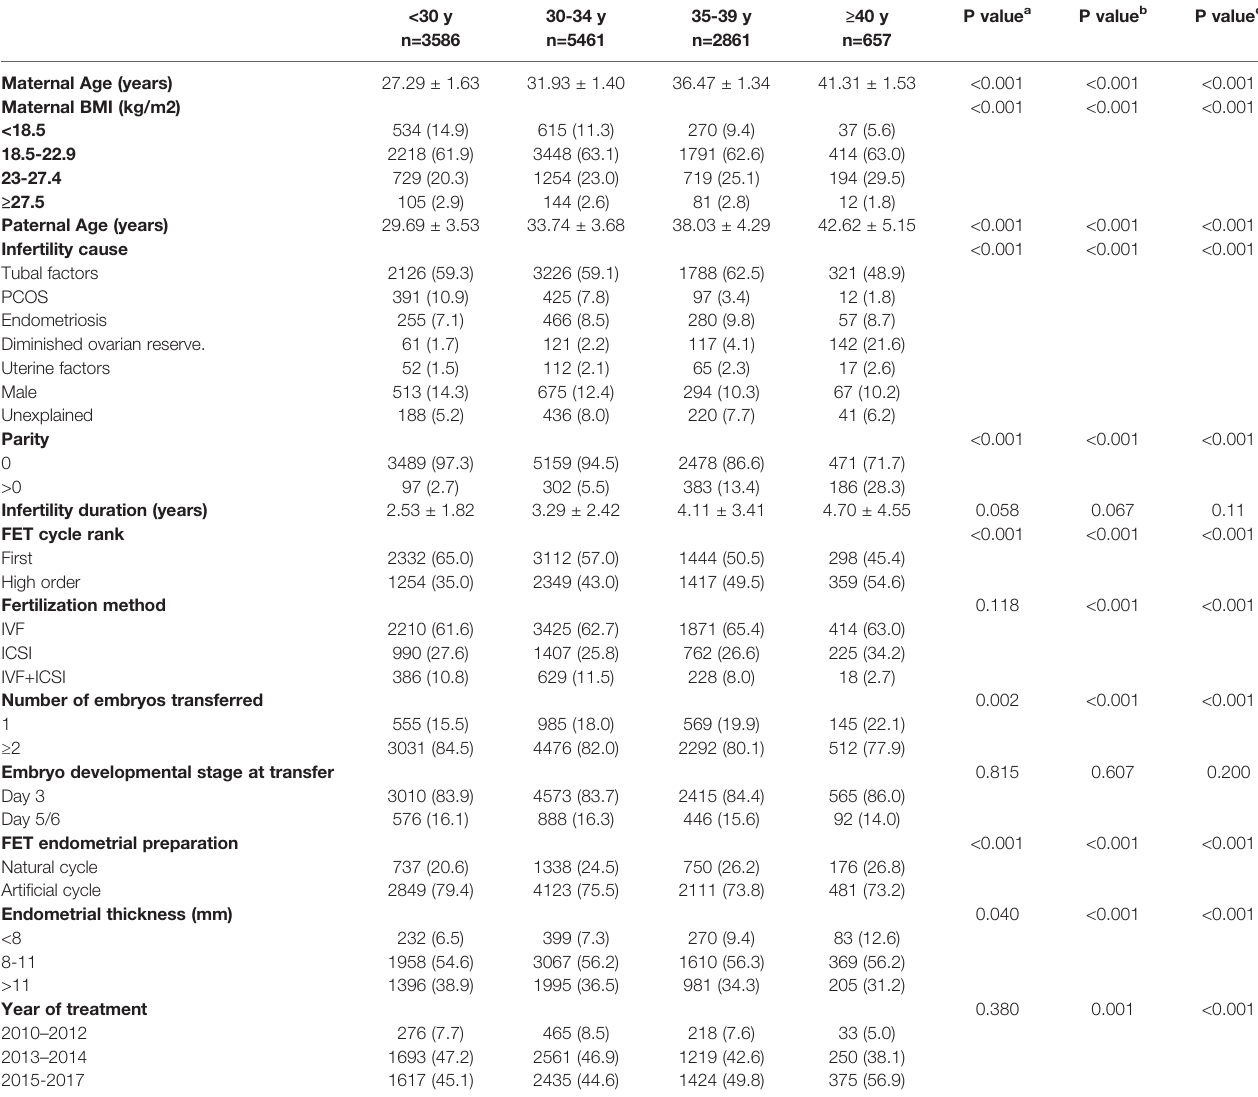
TABLE 1 | Patient treatment and demographic characteristics according to maternal